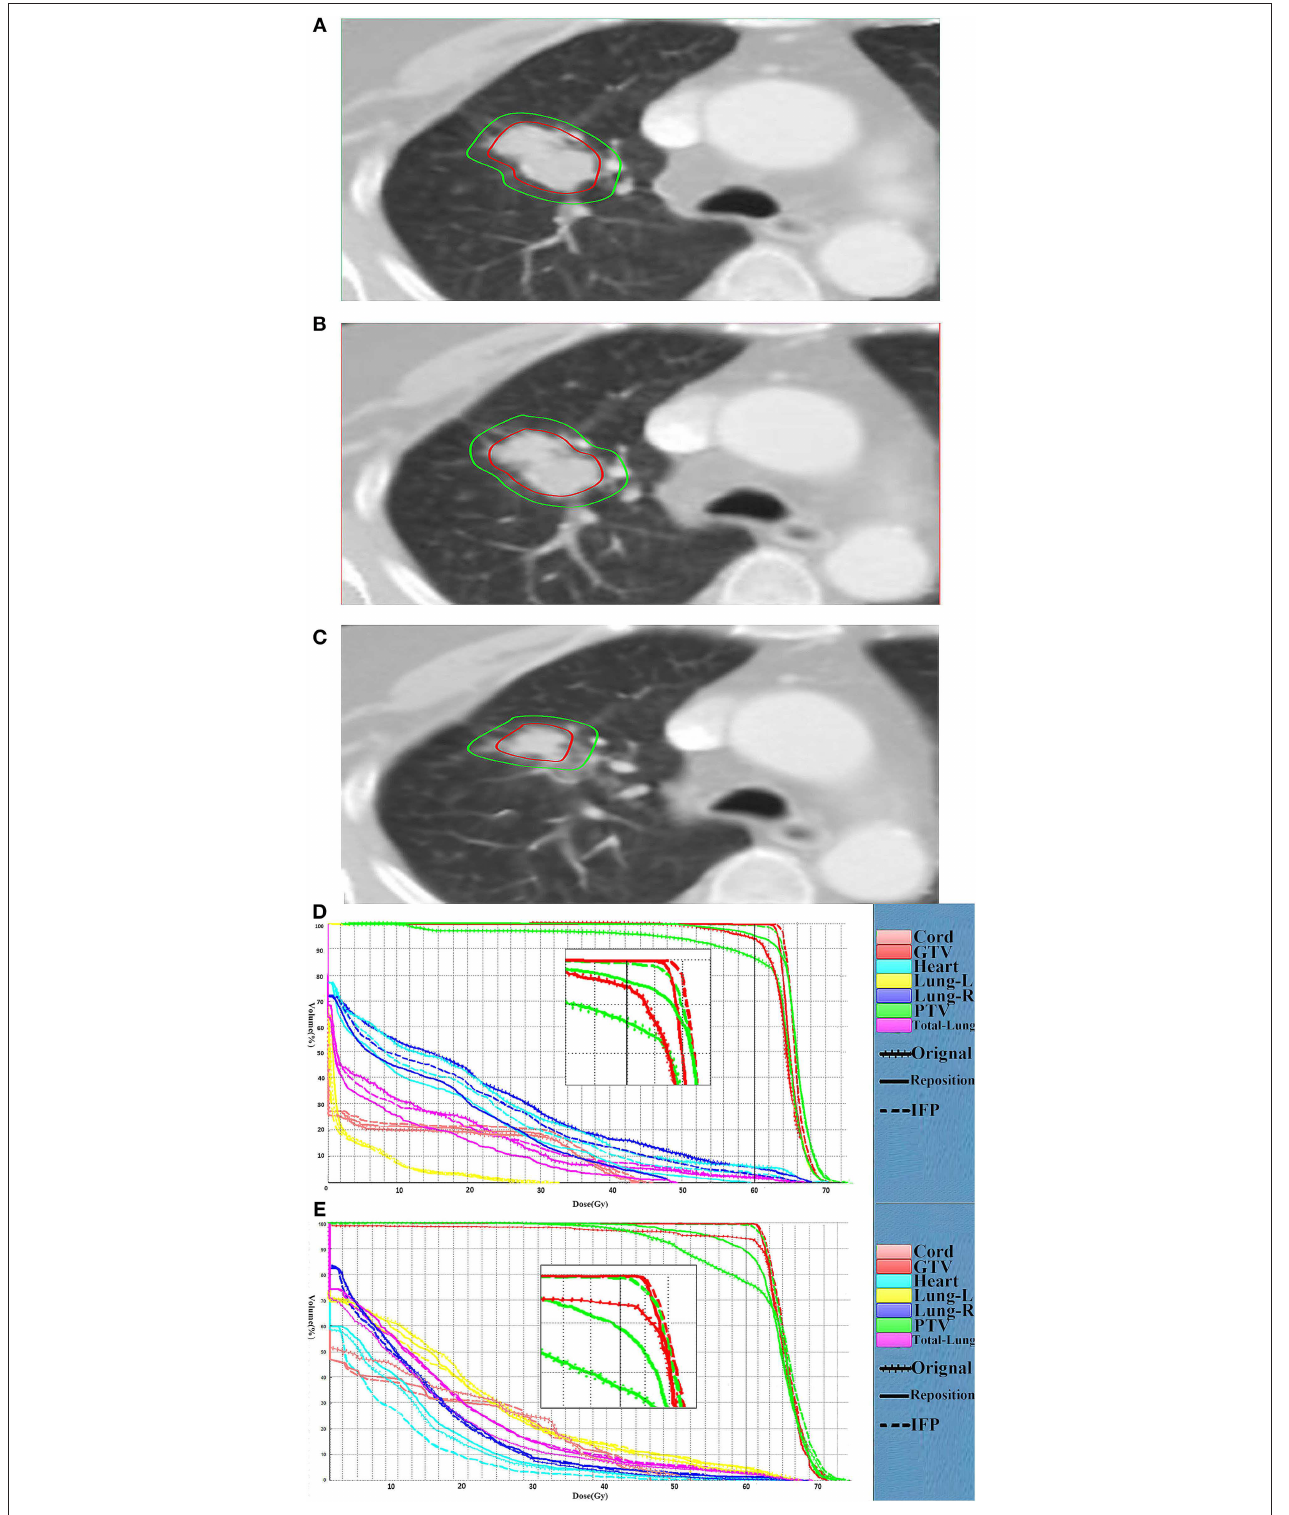
FIGURE 4 | Comparison of the target volume in the representative CT slice. Comparison of the target volume in the representative CT slice obtained on the CT-plan (A) , the corrected CT of fraction 6 (B) and the corrected CT (C) of fraction 16, and DVH curves comparison for the fraction 6 (D) and fraction 16 (E) for patient 1. The dotted, dashes, and solid curves represent the original, IFP and the repositioning plans, respectively.